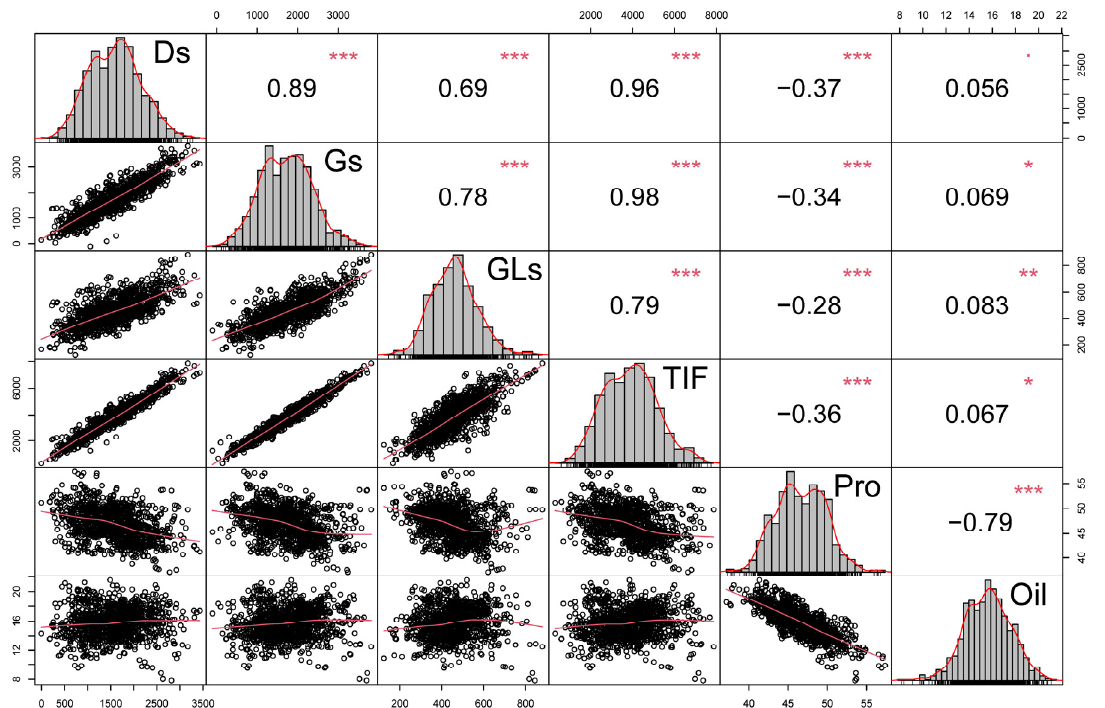
Figure 2. Correlation analysis of isoflavone, protein and oil content. Histograms of trait distributions are located in the diagonal cells. Correlation coefficients with significance levels are presented above the diagonal, while scatter plots with fitted curves are presented below the diagonal. Red asterisks indicate the significance of differences in RILs as determined by the Student’s t -test at 0.05 (*), 0.01 (**) and 0.001 (***) significance levels.